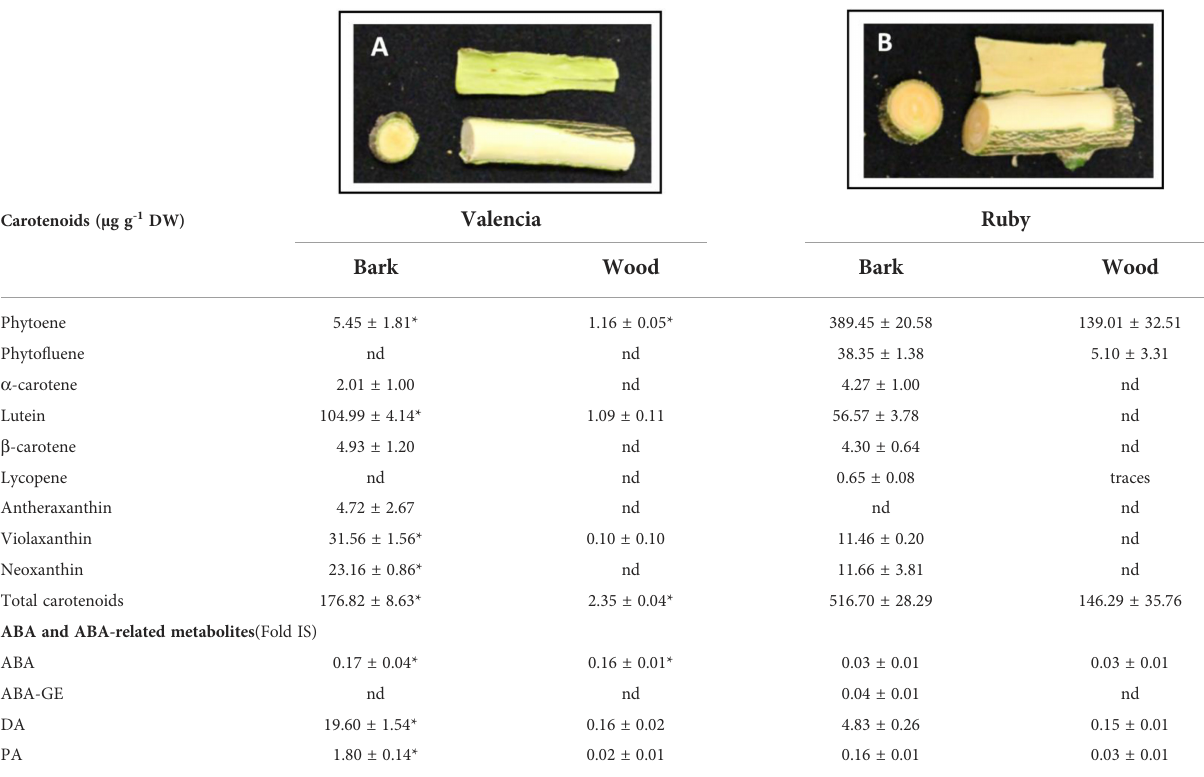
TABLE 4 Carotenoid content and composition (µg g -1 DW), and ABA, ABA-GE and ABA catabolites (Fold Internal Standard) levels in bark and wood of young stems of Valencia late (A) and Ruby Valencia mutant (B) orange trees.